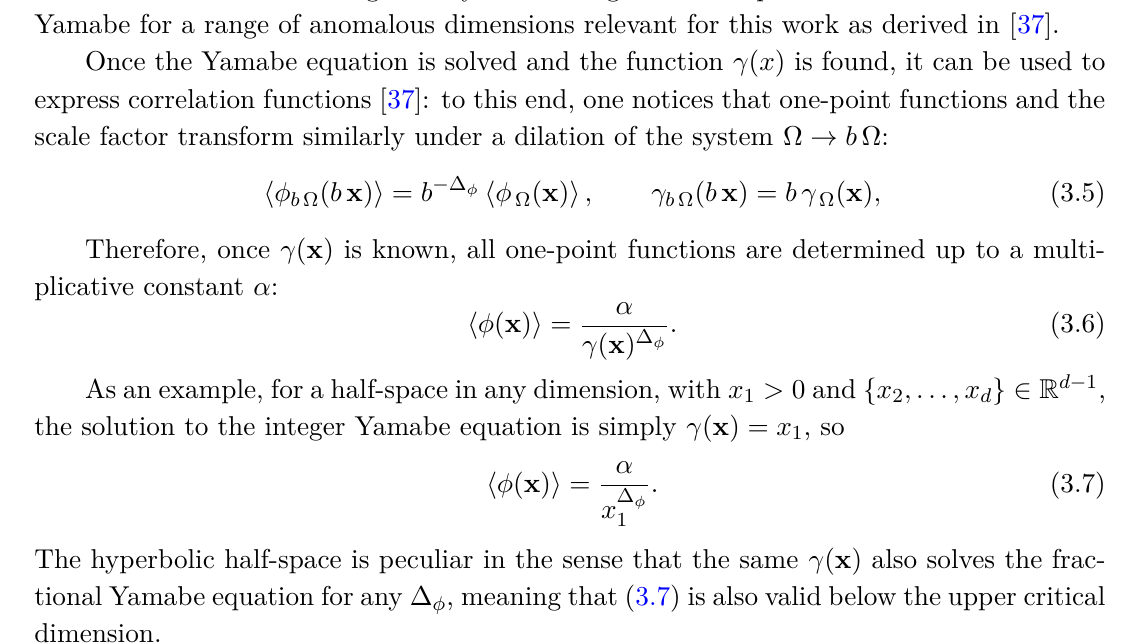
is varied φ = 1 / 2 integer Yamabe φ for the XY φ